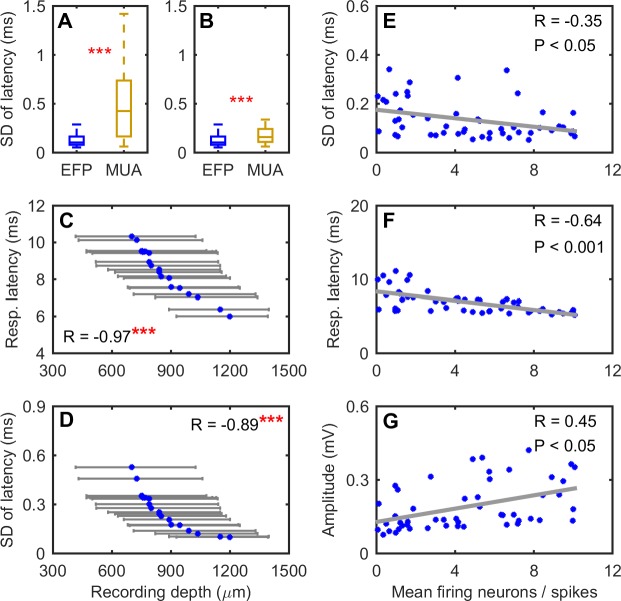
Properties of EFP.(A, B) EFPs (200–600 Hz) are more precise in timing stimulus onset than MUA. Data are based on a 90% detection reliability. The detection reliability refers to the probability at which MUA/EFP peaks were detected across all trials for the same sound stimulus. The MUA data in B were a subgroup of the original data in which values larger than the maximum of the data in the EFP group were excluded. (C, D) Topographical organization of the response latencies of the EFP (200–600 Hz). The recording depth is displayed as the median and quartiles for each detection reliability between 5% and 95% at a step of 5%. As indicated by the asterisks, the median recording depth was significantly correlated with the response latency and its variability. (E–G) The number of firing neurons affects the properties of the EFPs. The number of firing neurons refers to the average number of negative peaks whose amplitudes exceeded the detection threshold of the wideband signal (20–3,000 Hz; see Fig 1A and 1B) within a time window of ±3 ms relative to the averaged latency of the EFP over 80 repetitions. Data for this figure are included in S1 Data. EFP, extracellular field potential; MUA, multiunit activity.